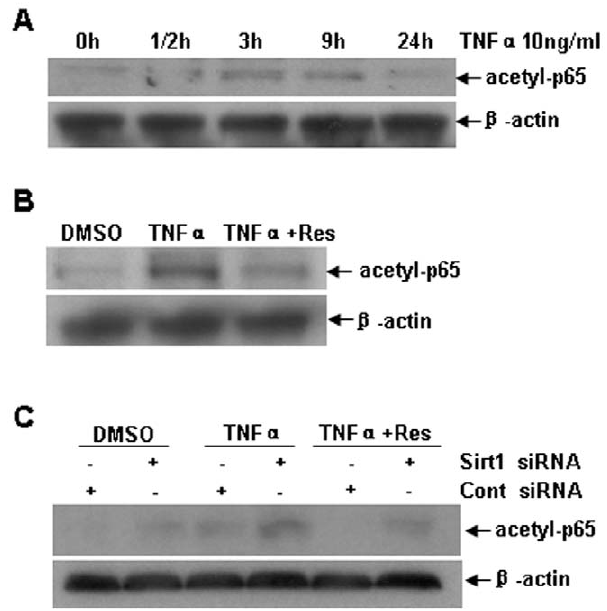
Figure 4. Resveratrol decreased acetylated RelA/p65. A. 3T3/NIH cells were treated with TNF- a (10 ng/ml) for 0, 1/2, 3, 9, 24 h, and acetyl-NF- k Bp65(Lys310) (acetyl-p65) expression was detected by western blotting analysis in cell lysis. B. Cells were pretreated by resveratrol (50 nM) in the presence of TNF- a treatment for 3 h, acetyl- NF- k Bp65(Lys310) expression were examined by western blotting analysis. C. Cells were transfected with Sirt1 or control siRNA for 72 h, then pretreated with resveratrol (50 nM) in the presence of TNF- a (10 ng/ml) treatment for 3 h. Western blotting analysis was used to detect acetyl-NF- k Bp65(Lys310)